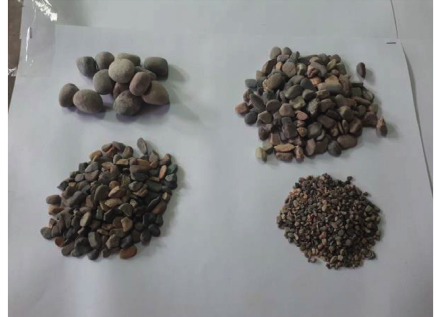
Figure 7: Round corner materials used.